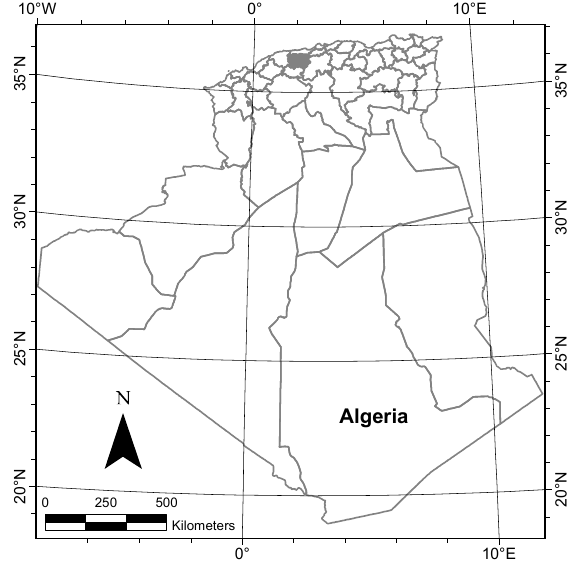
Figure 1: Map localisation of the studied area of Algeria.